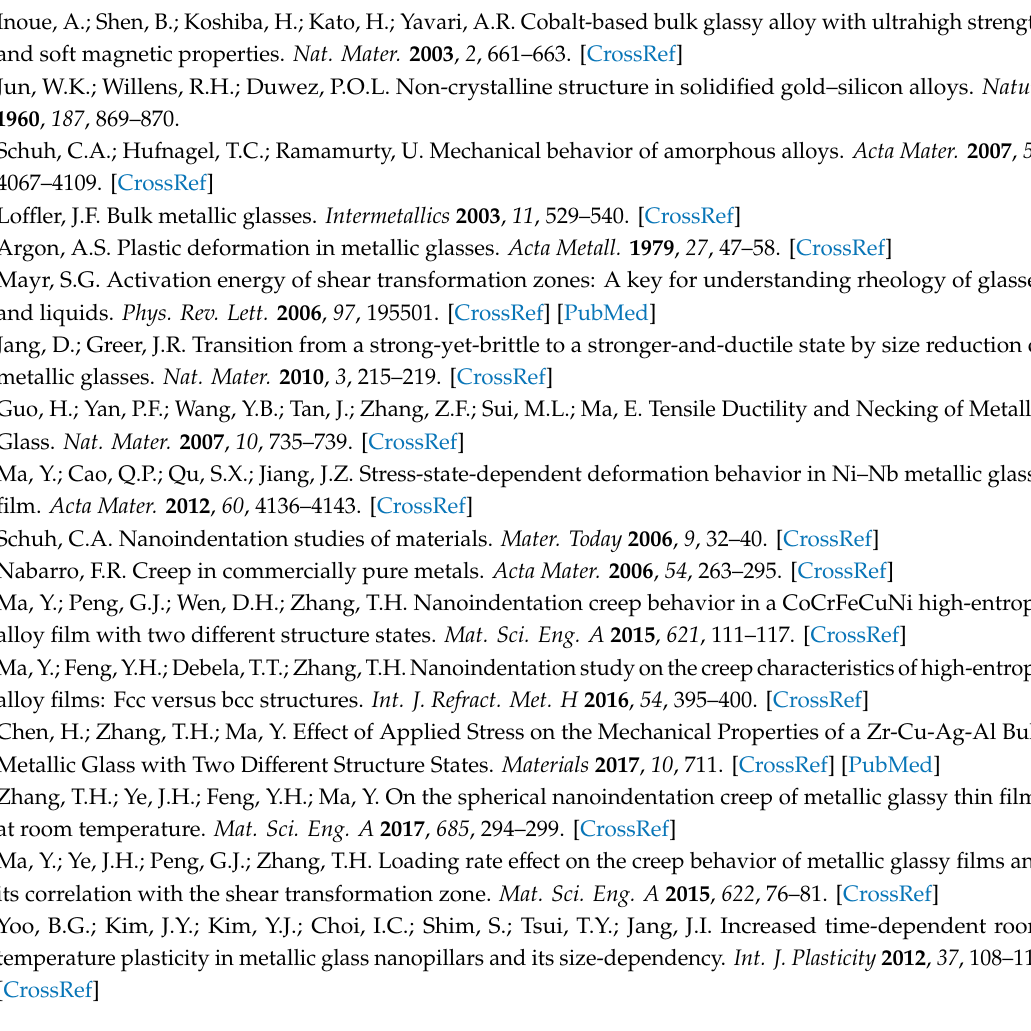
Figure S1: The typical XRD pattern of as-cast Zr-Cu-Ag-Al alloy, Figure S2: ( a ) The typical creep P-h curves at various holding depths under spherical indenter. P-h curves at shallow depths are enlarged in the inset. ( b ) Creep displacements at various holding loads were plotted with holding time, Figure S3: Elastic modulus was measured by continuous sti ff ness module (CSM) and was depicted as a function of displacement. The mean elastic modulus was 110